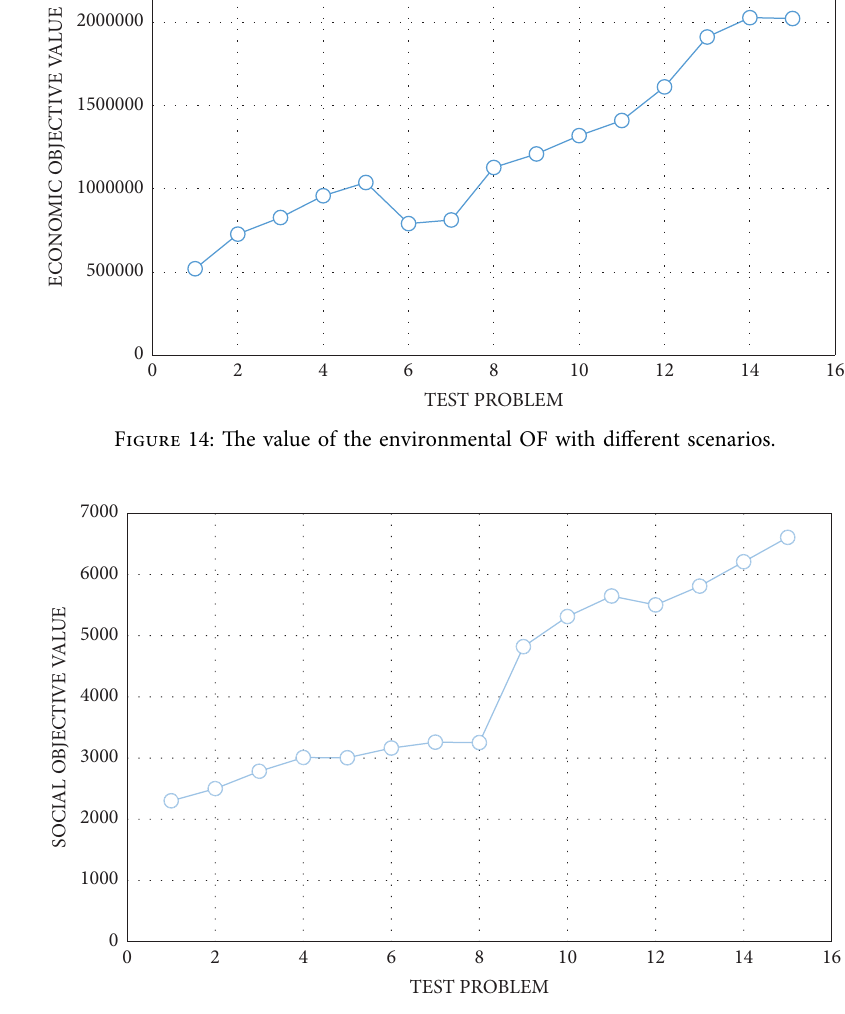
Figure 15: The value of the social OF with different